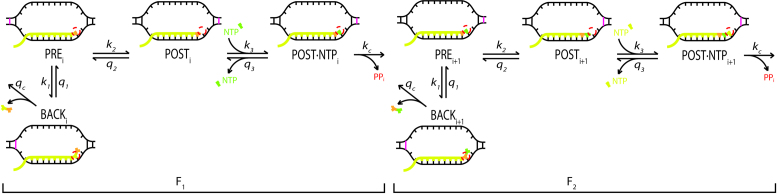
Two-step proofreading with transcription bubbles. The states and reactions are the same as in Figure 1. F1 corresponds to the first proofreading step and F2 to the second. In F1, a misincorporated base (orange) is in the last position of the transcript, and can be cleaved off or extended by next base incorporation (green). In F2, the previously misincorporated base (orange) can again be cleaved off, or extended by a next base incorporation (yellow), that is unaffected by the presence of the misincorporated base. The DNA is shown in black with 2 bp in magenta that mark the bounds of the involved base pairs in the two steps of proofreading. The RNA is shown in yellow, with the nucleotide subject to proofreading in orange and the next incorporated nucleotide in green.